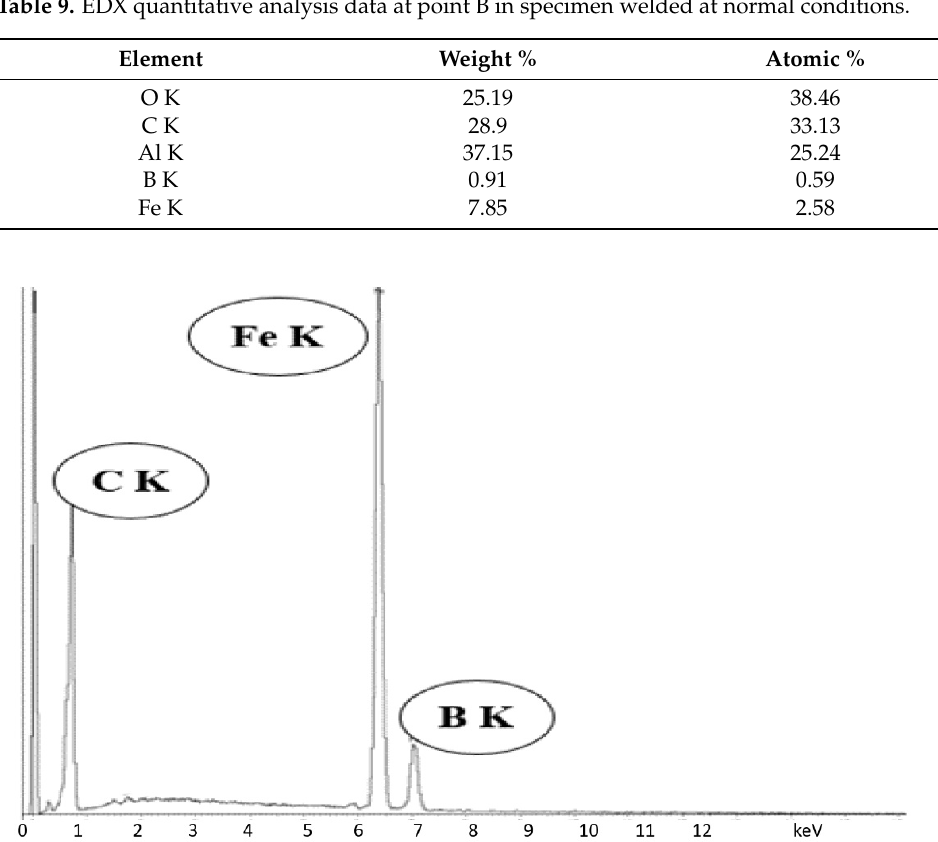
Figure 12. EDX analysis spectrum at point B in specimen welded at normal conditions. Table 9. EDX quantitative analysis data at point B in specimen welded at normal conditions.